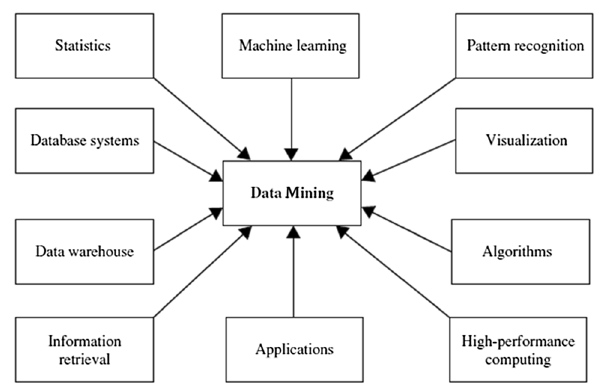
Fig. 4 Data mining adopts techniques from many domains (Han et al. 2012)